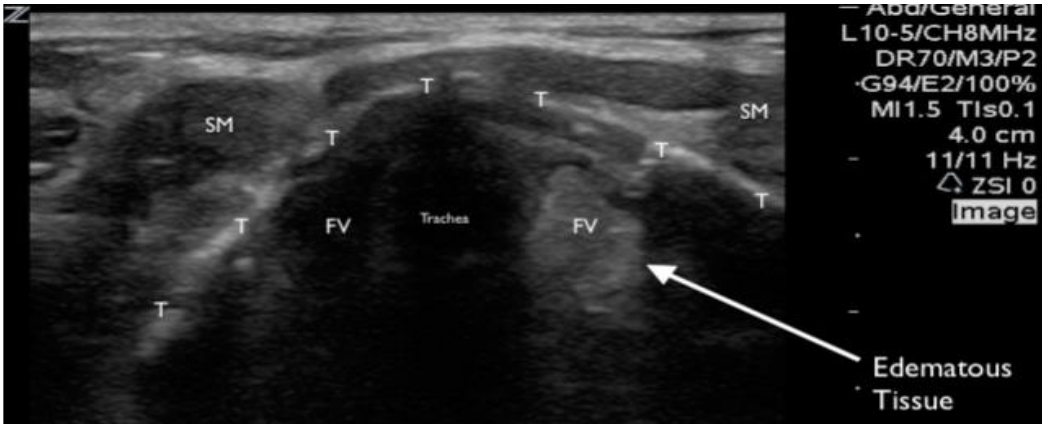
Figure 3. A transverse still image of the upper airway using the high frequency, linear transducer at the level just cephalad of the vocal cords and arytenoids. Asymmetry is identified with a hyperechoic fullness of the left side of the airway (right side of the image). This was immediately confirmed as subglottic edema at the level just cephalad of the vocal cords by indirect fiberoptic laryngoscopy.